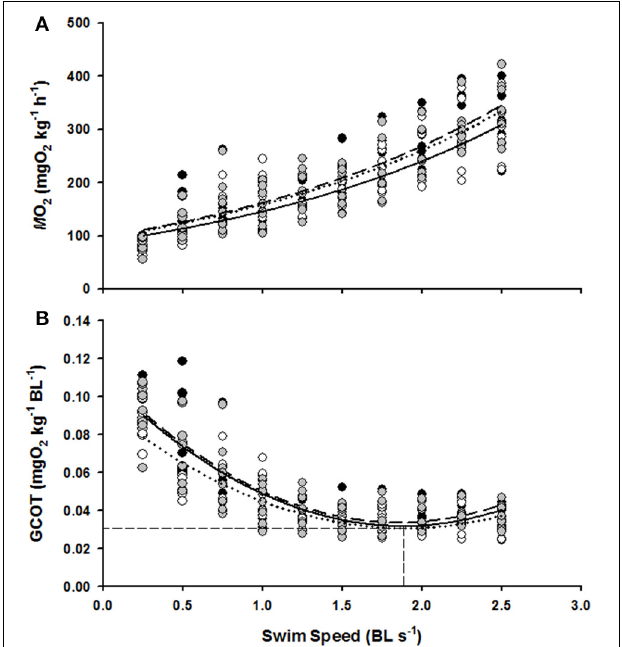
FIGURE 2 | The effect of swim flume speed (BL s − 1 ) on the M O 2 (A) and GCOT (B) of juvenile hapuku raised for 6 weeks at either 0.0 BL s − 1 (black circles, broken line), 0.75 BL s − 1 (open circles, dotted line), or 1.5 BL s − 1 (gray circles, solid line). M O 2 regressions are y = 90 . 38 e 0 . 5438 x , y = 79 . 47 e 0 . 5531 x , and y = 89 . 26 e 0 . 5399 x , respectively. GCOT regressions are y = 0 . 023 x 2 − 0 . 084 x + 0 . 111, y = 0 . 018 x 2 − 0 . 067 x + 0 . 094, and y = 0 . 021 x 2 − 0 . 081 x + 0 . 109, respectively. As no significant differences were detected between ER treatments in GCOT (see Results), the horizontal dashed lines refers to the calculated pooled GCOT min (0.03mg O 2 kg − 1 BL − 1 ) and the vertical dashed line refers to pooled U opt (1.86 BL s − 1